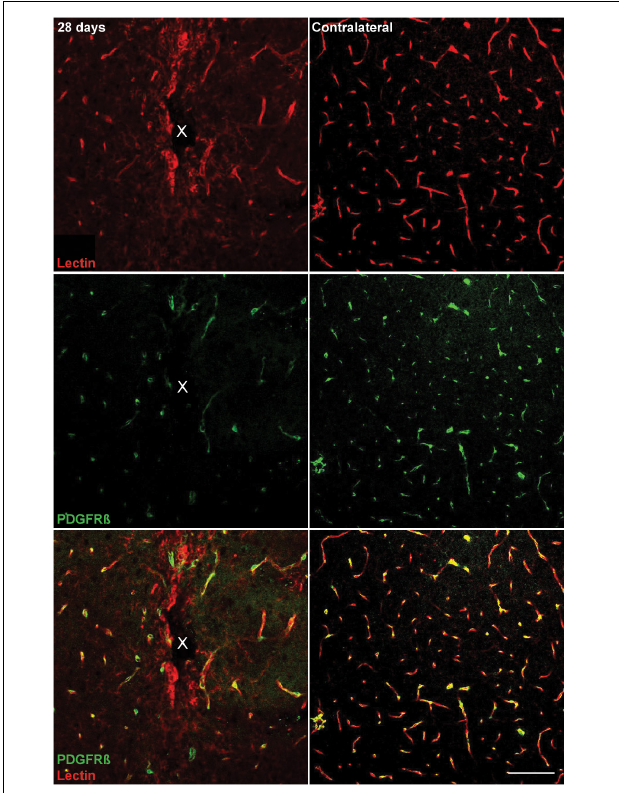
FIGURE 7 | Reduced vascular structures around implanted microelectrode arrays at 28 days post-implantation. Chronic microelectrode implantation reveals specific insult to the endothelial component of the BBB, which may precede pericyte reactivity, vessel permeability, and leakage of plasma components. Blood vessels as well as vessel-bound pericytes are visualized by representative immunohistochemical stains for lectin (red) and PDGFR- β (green) at 28 days post-implantation compared to contralateral (non-implant) side. Center of the probe hole is denoted by a white “x.” Scale bar = 100 µ